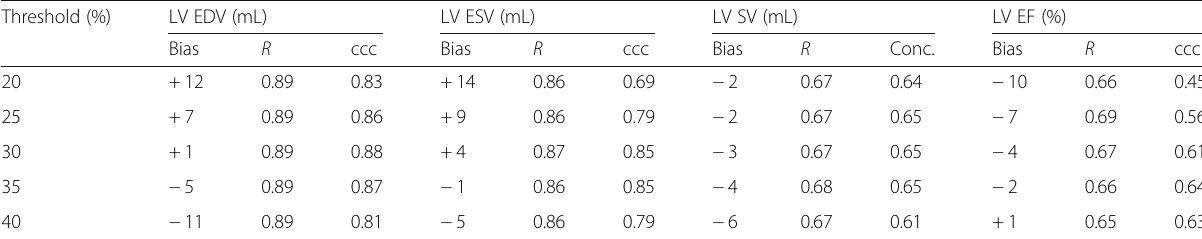
Table 4 Bias, Prearson ’ s correlation ( R ), and Lin ’ s concordance (ccc) between first-pass PET and myocardial SPECT LV functional parameters according to the LV segmentation threshold Threshold (%)